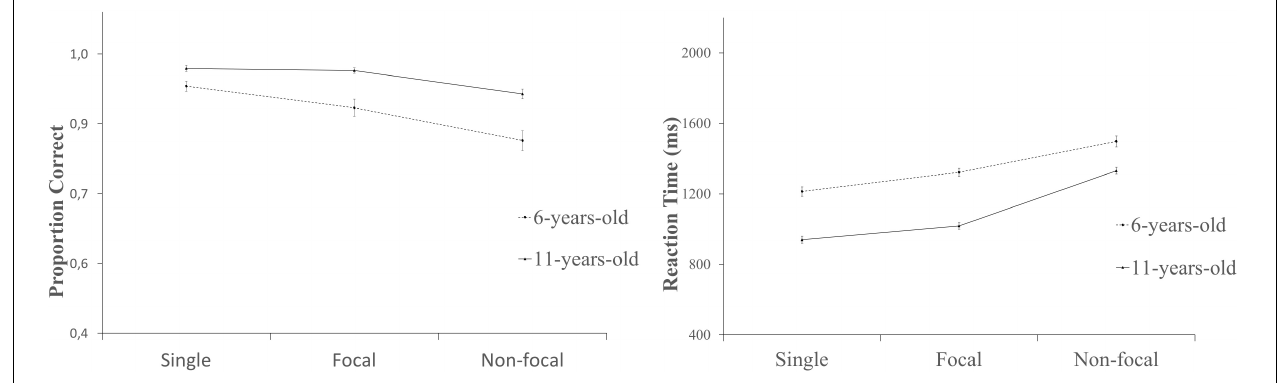
FIGURE 1 | Ongoing performance. (A) Proportion of correct responses as a function of age and condition. (B) Reaction time as a function of age and condition. Error bars represent standard